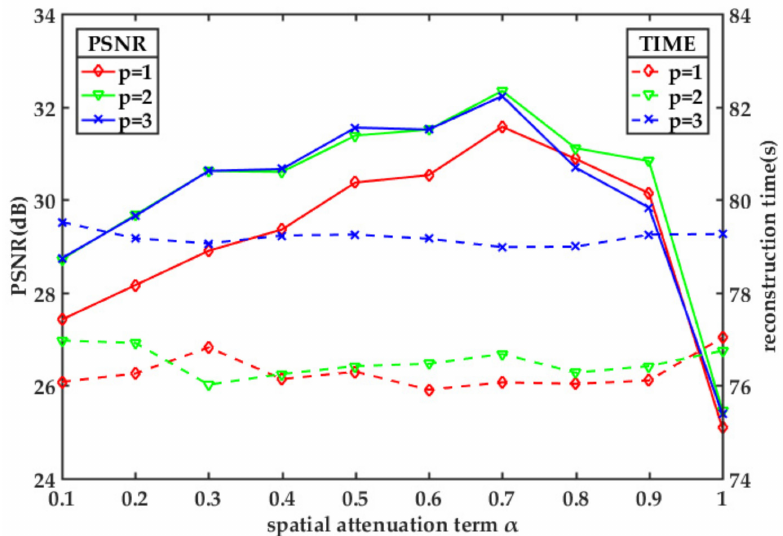
Figure 3. The PSNR (dB) and reconstruction time(s) of the Monarch image with different spatial attenuation term α and filter window size p reconstructed by the proposed